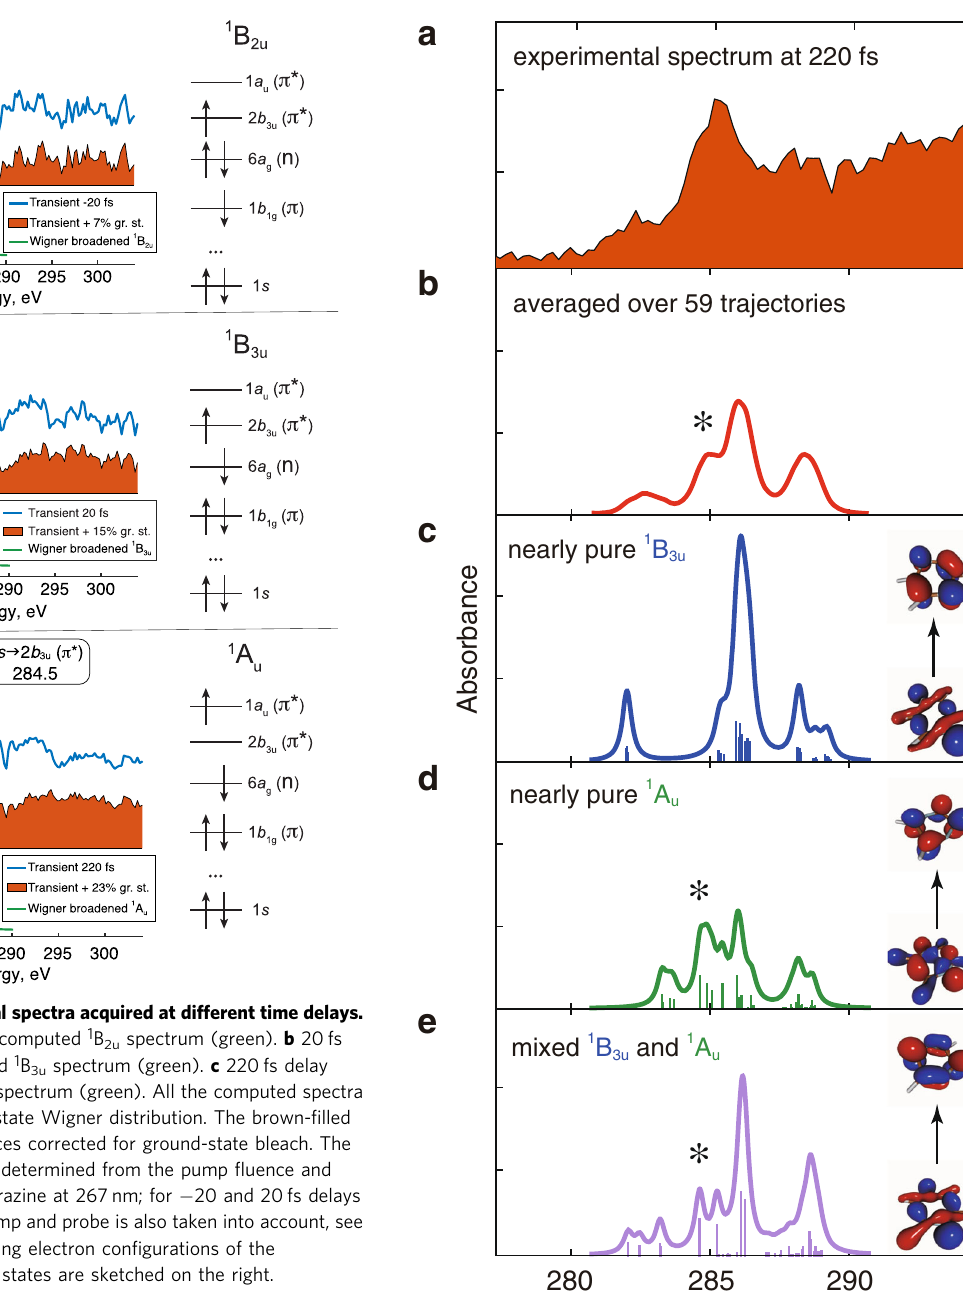
(n) transition at 281.4 eV and the lowest-energy experimental feature peaking at 282.3 eV is rationalized by the nuclear motion — in the fi rst 220 fs the wave packet will have departed from the FC vicinity. For this reason, we investigate the implication of the nuclear motion on the X-ray resonances by calculating the spectra of the excited states averaged over the 59 trajectories from the fewest- switches surface hopping (FSSH) simulation at 220 fs (red curve in Fig. 6b) — at this time point, only two trajectories remain in the 1 B 2u state and the other 57 trajectories are in the lowest excited state having a mixed 1 B 3u / 1 A u character. The computed averaged spectrum (red trace) exhibits a very good agreement with the experimental one (brown area in Fig. 6a, same as that in Fig. 5c) in the X-ray region below ionization energy.